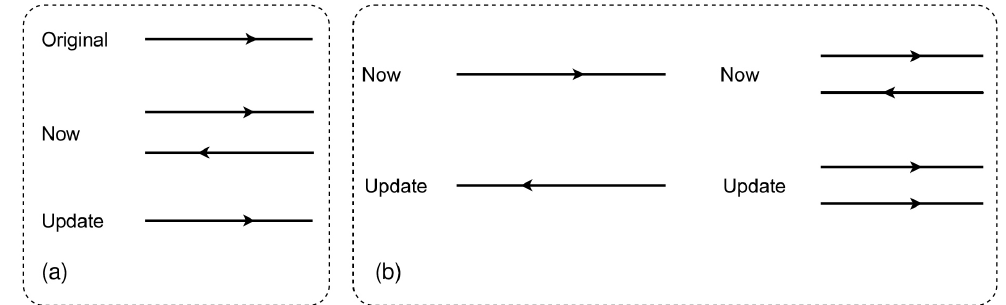
Figure 4. Categories of problematic road segments: ( a ) road segments that are not updated promptly; ( b ) road segments that are updated incorrectly with respect to their